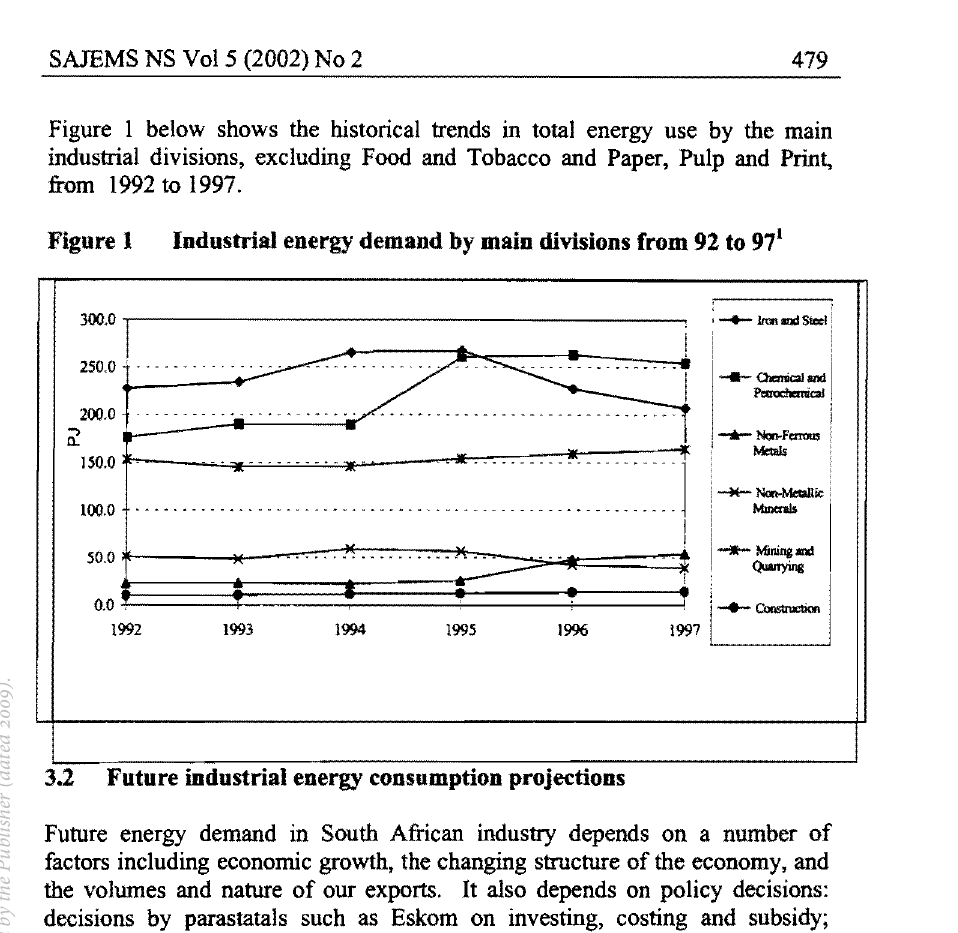
Industrial energy demand by main divisions from 92 to 97 1